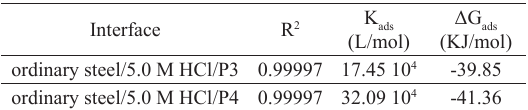
Table 6. Calculated parameters of the adsorption of P3 and P4 on ordinary steel surface.